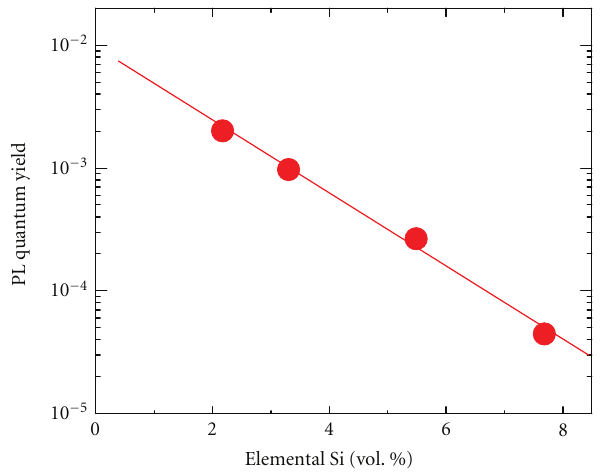
Figure 13: PL quantum yield (in arbitrary units) as a function of the amount of elemental Si in SiO x films